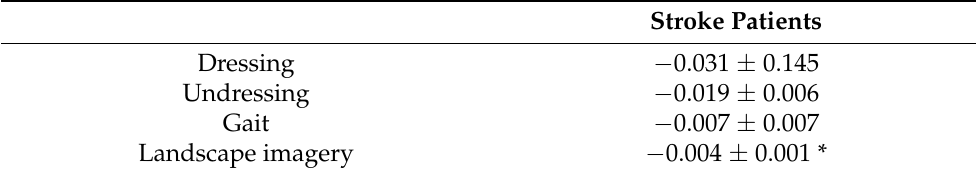
Table 3. Average mu power log ratio of C3, CZ and C4.